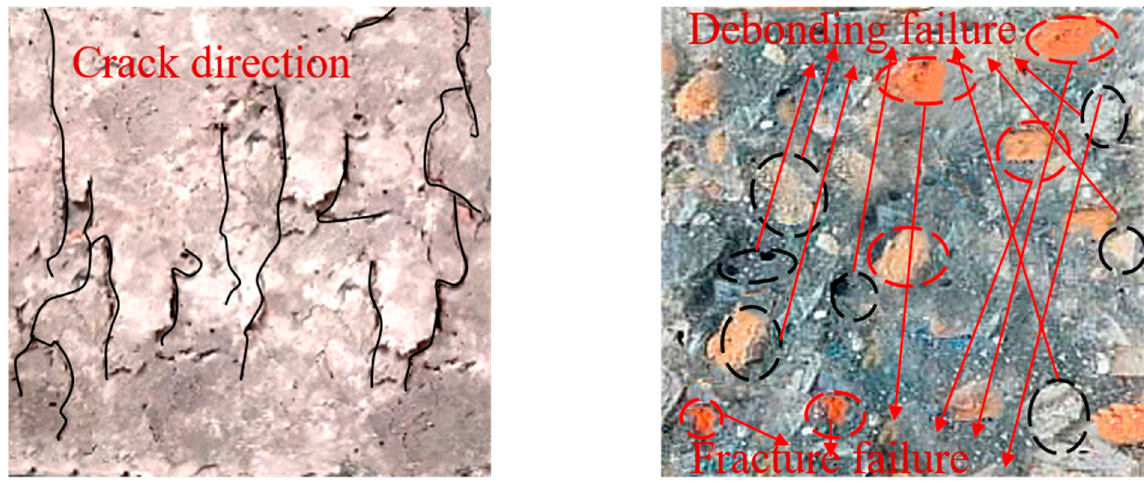
Figure 9. Specimen failure crack and failure interface morphology.